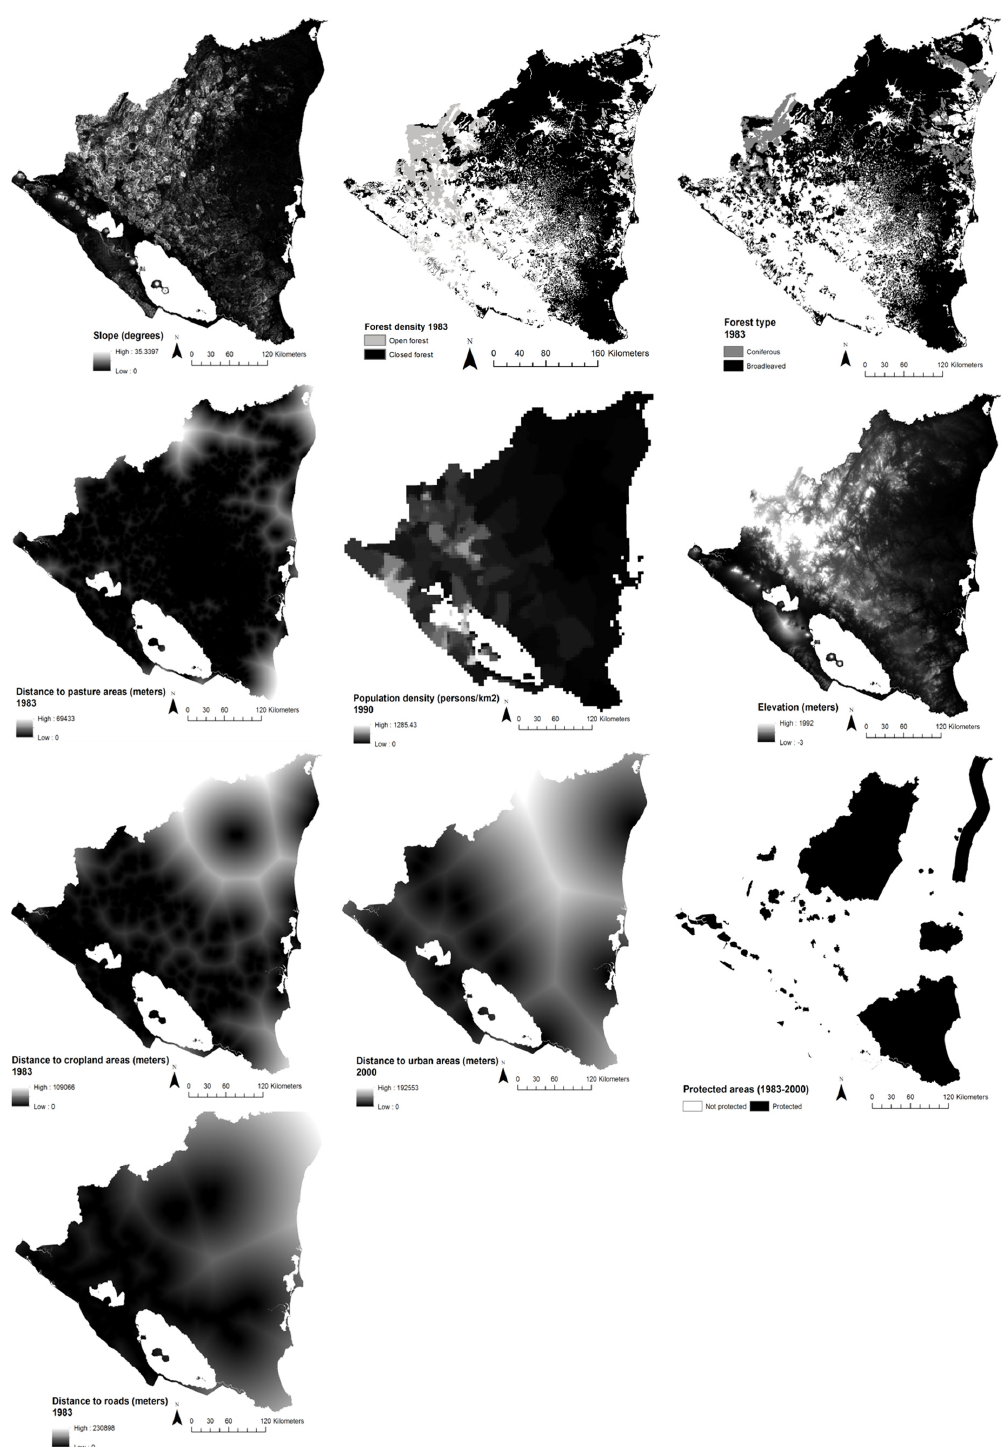
Figure 3. Spatial independent variables of Nicaragua used in the calibration of the model. Ordinary linear kriging was applied to predict the risk of the dependent variable at a non ‐ sampled location, i.e., for the whole forested areas in 2000 [47]. The simulated t3 map created using kriging has a pixel resolution of 150 m—higher resolution was not possible due to